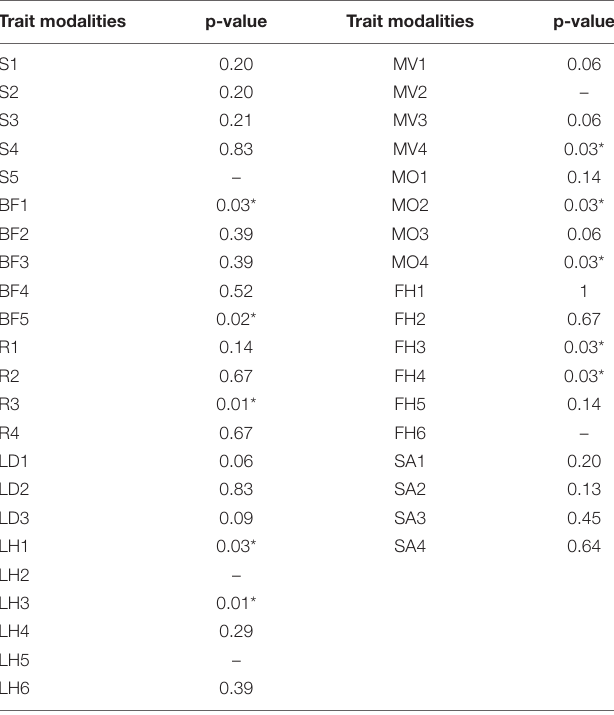
TABLE 4 | Results of Kruskal–Wallis test comparing proportional abundance of modalities at deep and mid-depth stations for ROV data of epibenthos in the Arctic Chukchi